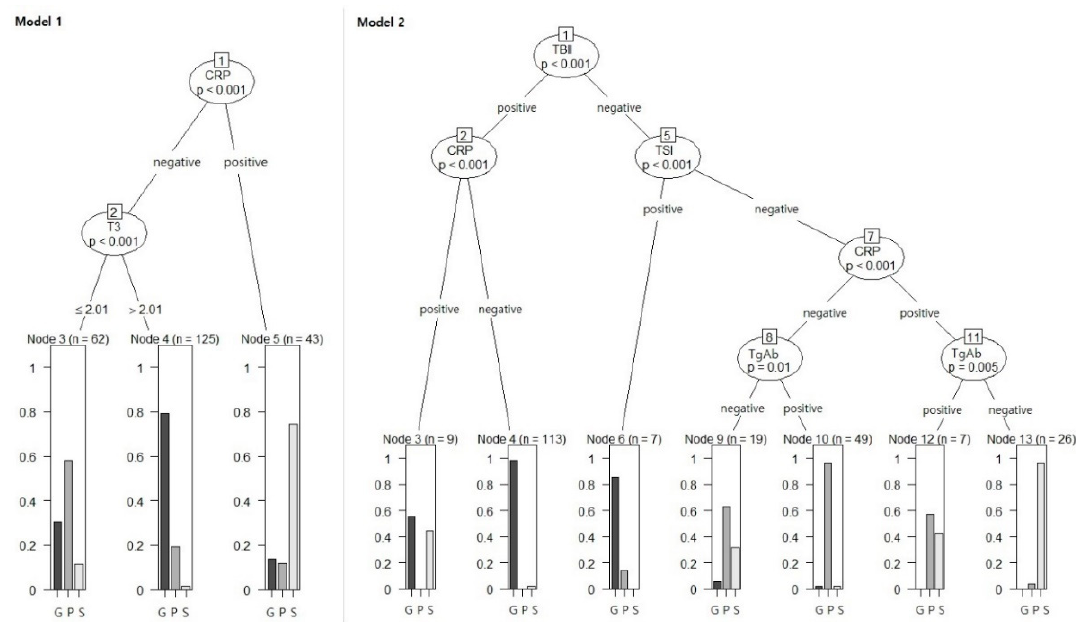
Figure 3. Decision tree models for Model 1 and Model 2. Node numbering for the decision trees presented inside the box. Classification according to the decision tree is described at the end of the tree, and the bar graph indicates the final diagnosis according to the clinical course. G,